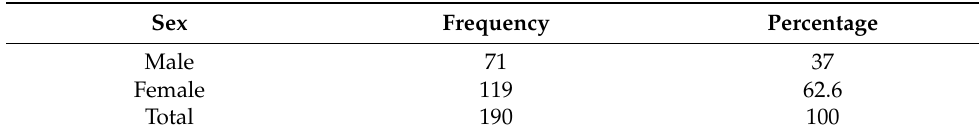
Table 1. Absolute frequency for percentage and categories.